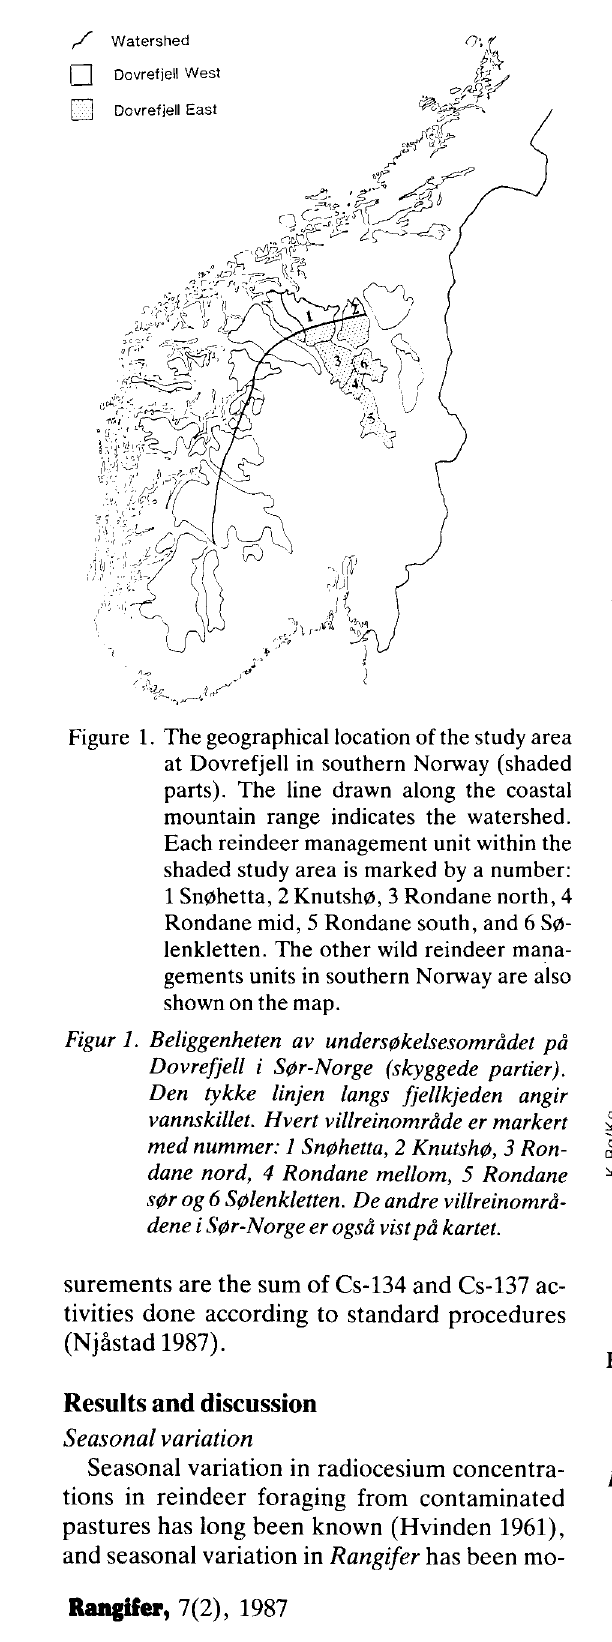
Figure 2. Seasonal radiocesium concentrations in wild reindeer east of the watershed at Dov refjell. The number of sampled animals is shown on the graph. Figur 2. Variasjonen i konsentrasjonen av radiocesi um hos villrein øst for vannskillet på Dovre fjell. Antall undersøkte rein er vist på figu